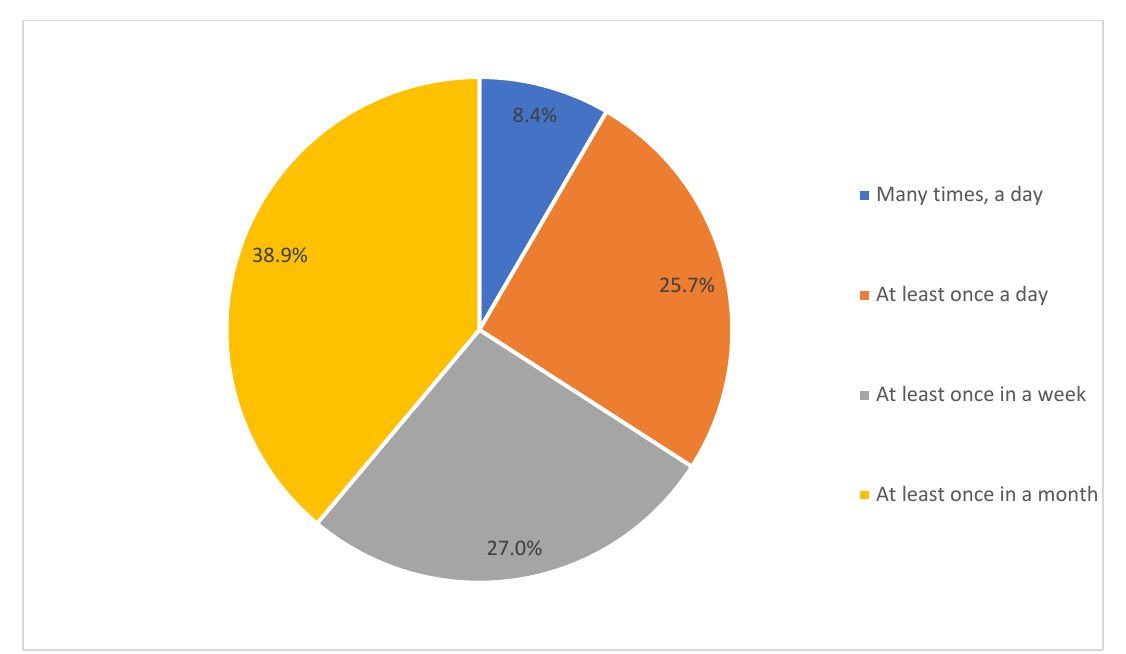
Figure 3. Participants’ frequency of using eHealth applications.